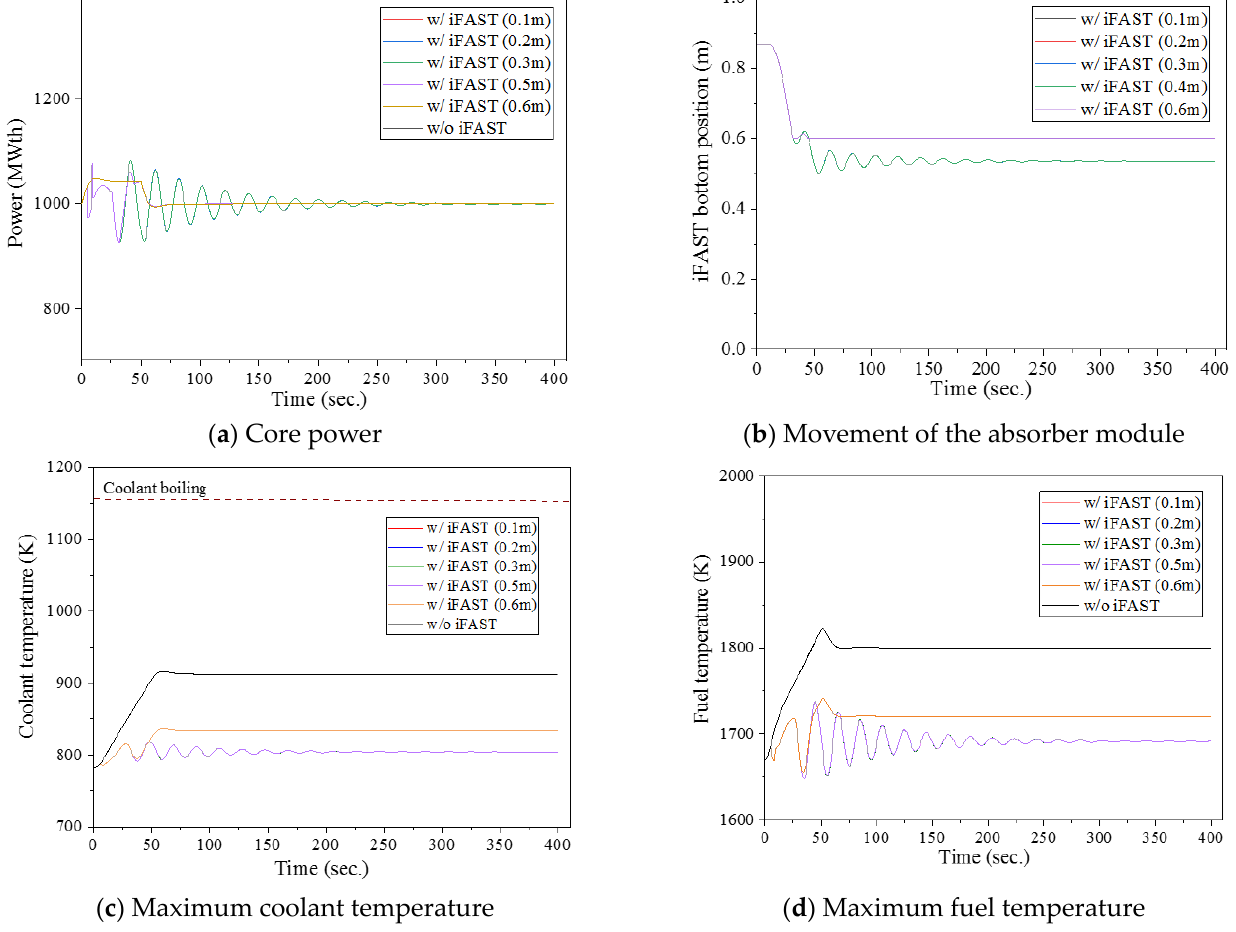
Figure 8. Unprotected transient over power (0.4$/50 s) with a constant temperature drop in IHX and 1.8$ maximum iFAST worth.